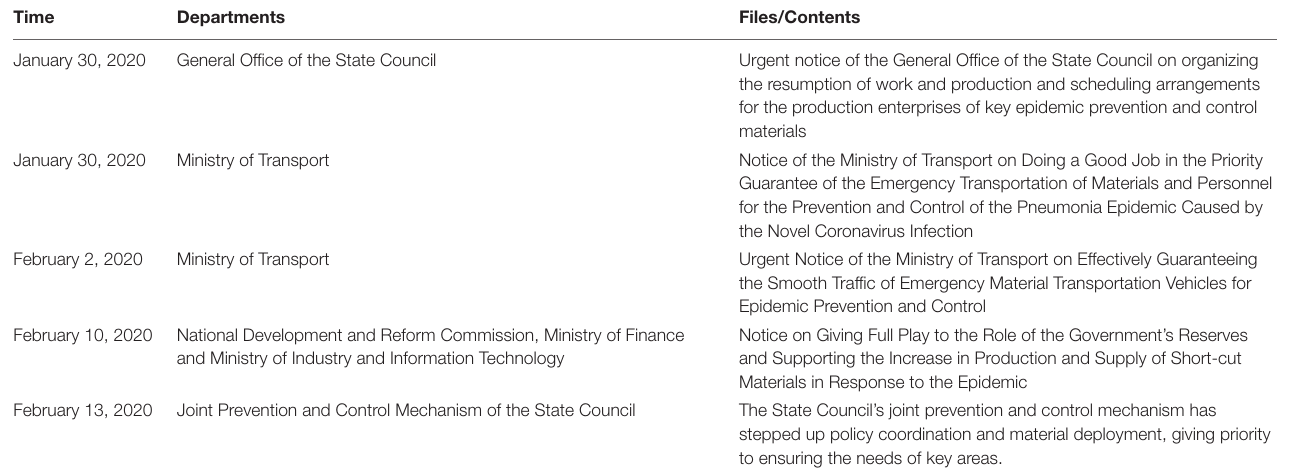
TABLE 4 | Relevant policy